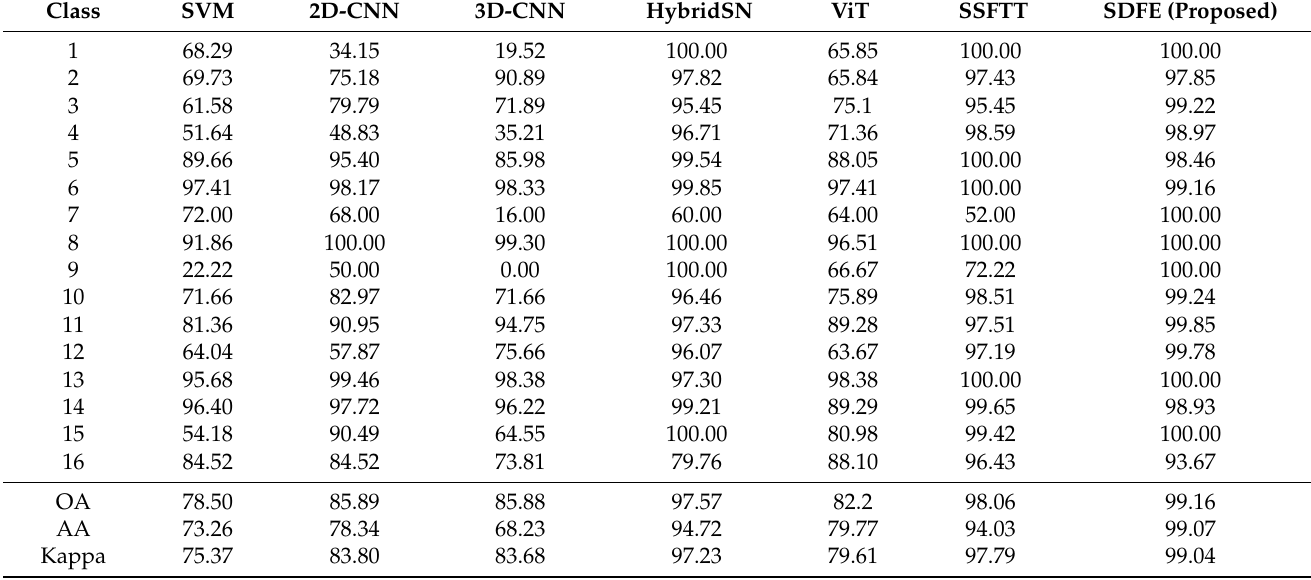
Table 10. The classification results (in percent) using SDFE and other baselines for the IP